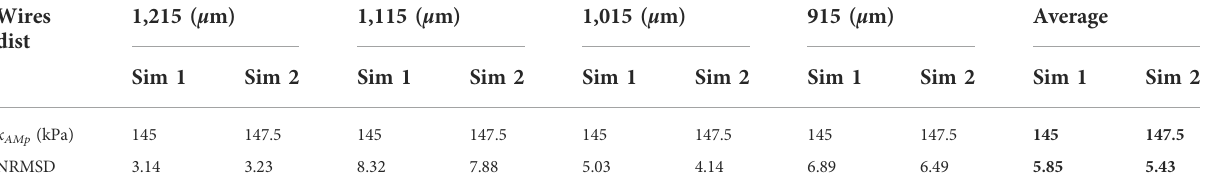
TABLE 2 Normalized root-mean-square deviation for different κ AMp